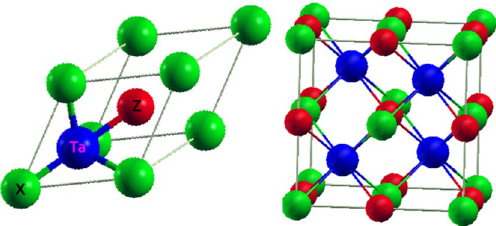
Figure 1. Primitive cell of XTaZ molecule and lattice structure in F-43m configuration. Green balls represent X(Pd/Pt), Blue represent Ta atoms and red spheres represent Z(Al/Ga/In) atoms,